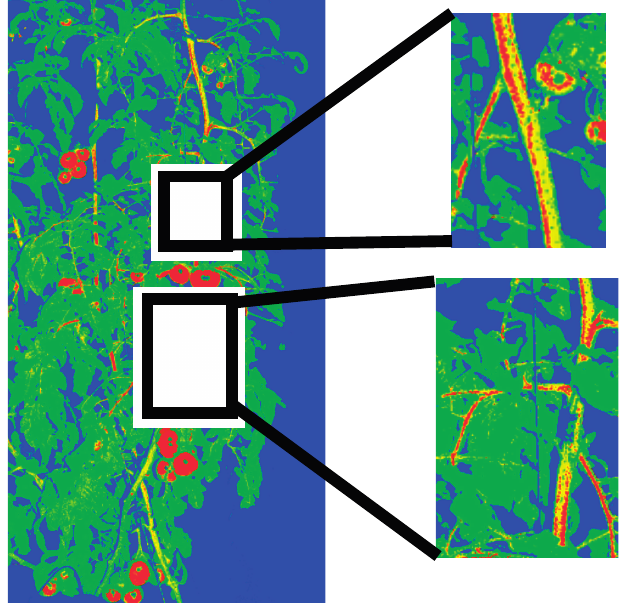
Figure 7. Examples of pixels misclassified by pixel-based segmentation. In particular, the stem parts tend to be misclassified as the fruit class.